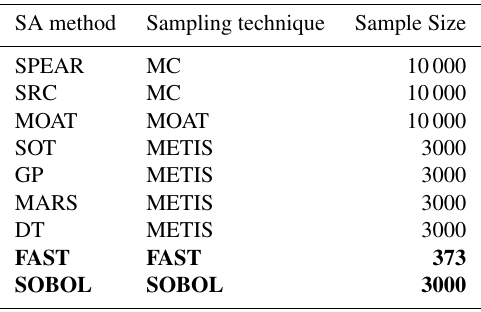
Table 3. Setup for SA. Qualitative methods in black font. Quantita- tive methods in bold